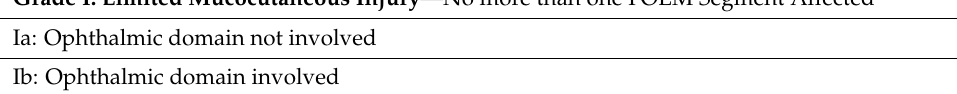
Table 3. The FOEM (facial, ophthalmic, distal external carotid, and internal maxillary) grading classification of mucocutaneous ischemic injuries. From Soares et al.